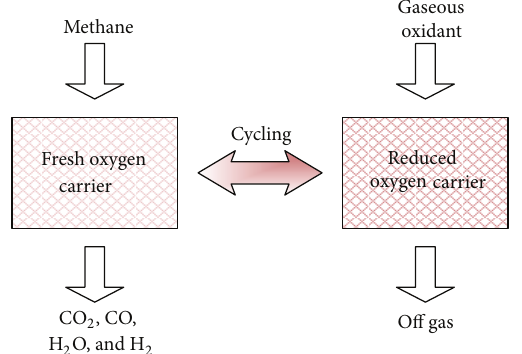
Figure 1: Schematic of chemical-looping concept for methane